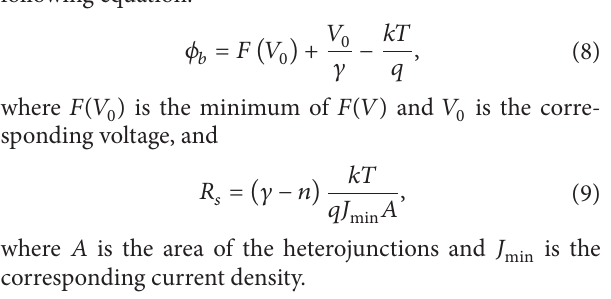
Figure 6: Relationship between d 𝑉/ d ( ln 𝐽) - 𝐽 (left axis) and 𝐻(𝐽) - 𝐽 (right axis) at temperatures of (a) 300 K and (b) 20